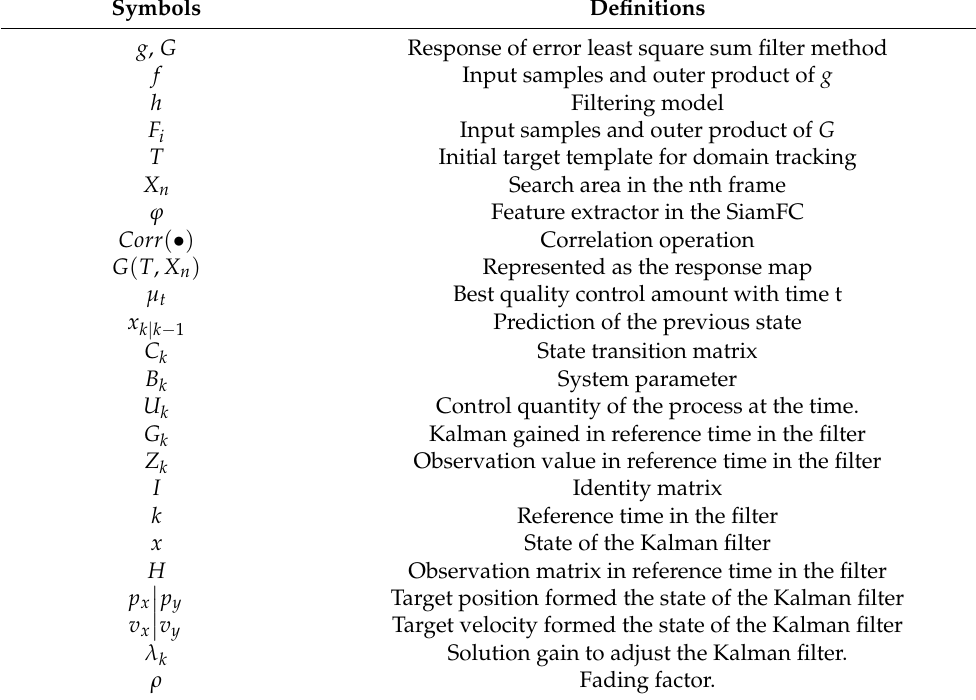
Table 1. Definition of